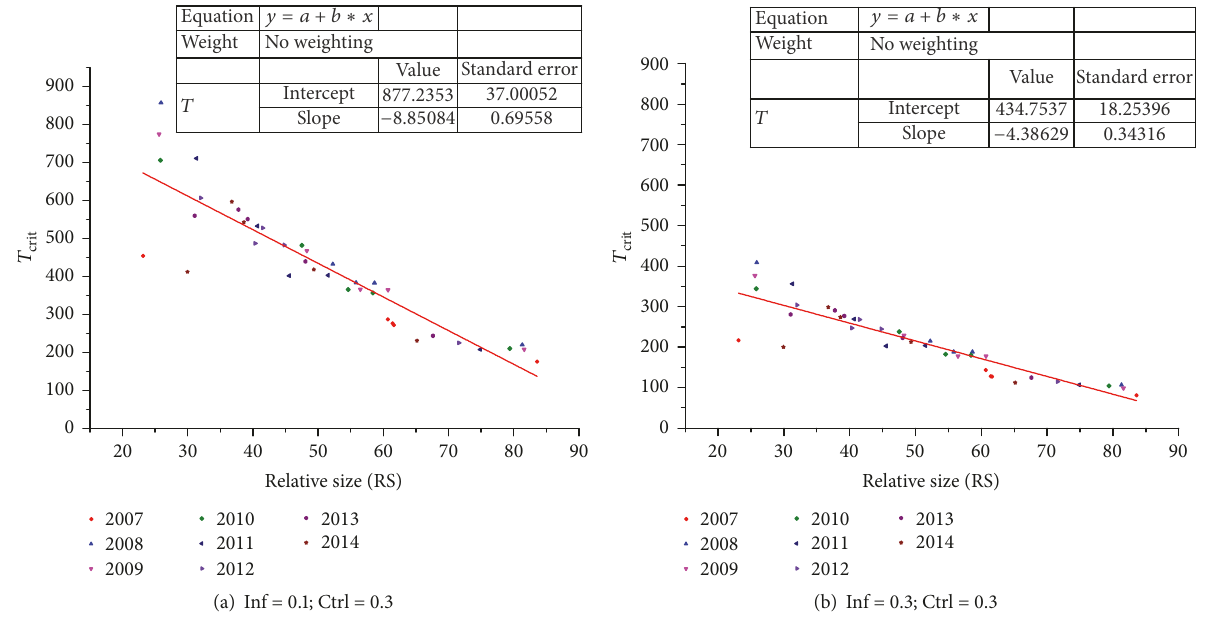
Figure 6: The relation between relative size (RS) and systemic importance ( 𝑇 crit ) of